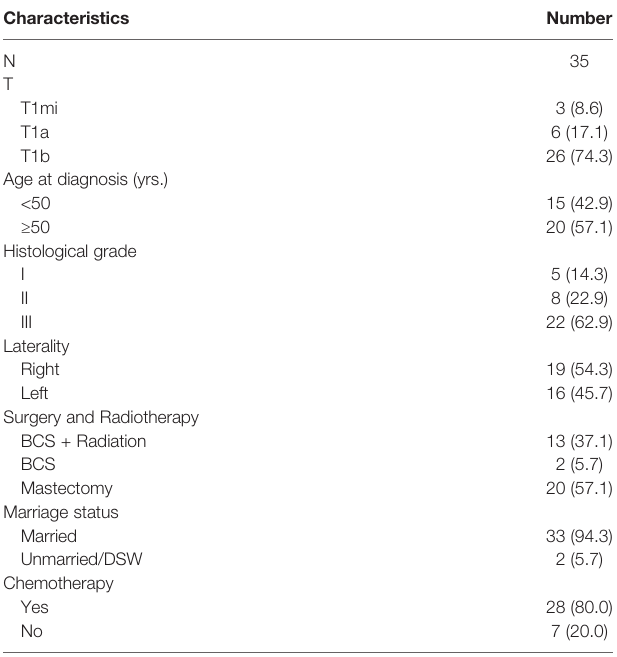
BCS, breast conserving surgery.